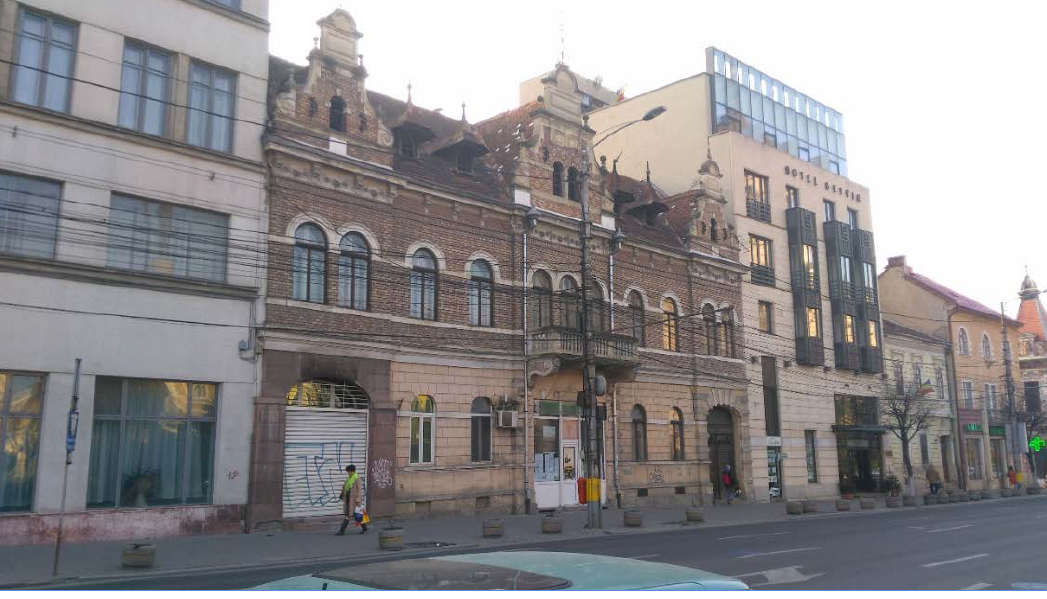
Figure 20: New hybrid cultural landscape in Avram Iancu Square – Contemporary civil engineering insertions into old town architecture Source: Emanuel- Cristian ADOREAN,